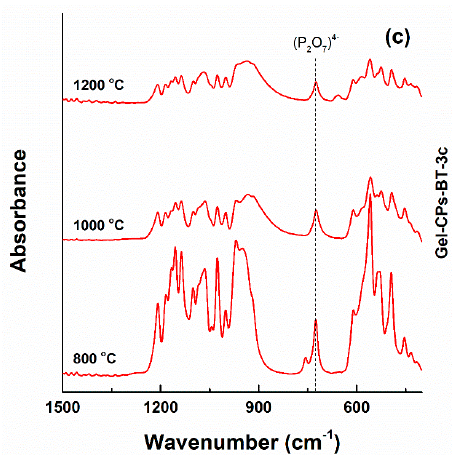
Figure 8. FTIR spectra of the obtained materials: ( a ) before the thermal treatments and ( b and c ) after the thermal treatments.